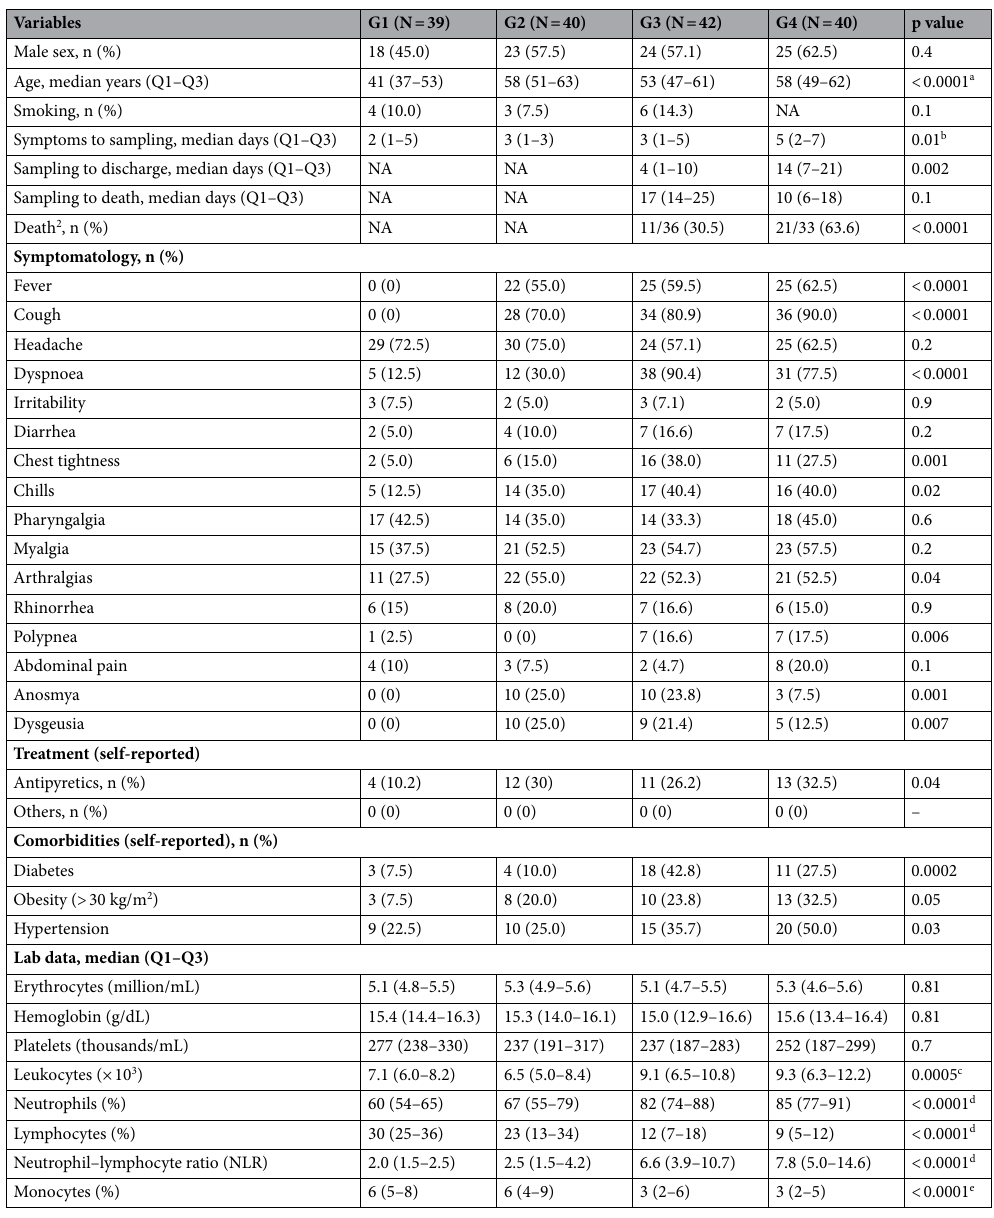
Table 1. Baseline characteristics of non-COVID-19 and COVID-19 patients at admission. Continuous variables were compared using Mann–Whitney U tests or Kruskal–Wallis tests and categorical variables (sex, smoking, death, symptoms, and comorbidities) were compared using the chi-square test for trend, with p values of less than 0.05 considered statistically significant. The analyses were conducted using GraphPad Prism version 8.0.1 for Windows (GraphPad Software, La Jolla California USA). a G1 vs. G2; G1 vs. G3; G1 vs. G4. b G1 vs. G4. c G1 vs. G4; G2 vs. G3; G2 vs. G4. d G1 vs. G3; G1 vs. G4; G2 vs. G3; G2 vs. G4. e G1 vs. G3; G1 vs. G4; G2 vs. G4. 1 G1: PCR−/controls, G2: PCR+/not hospitalized, G3: PCR+/hospitalized, and G4: PCR+/ intubated. 2 The number (n) is referred to the confirmed data based on clinical and epidemiological records and supported by death